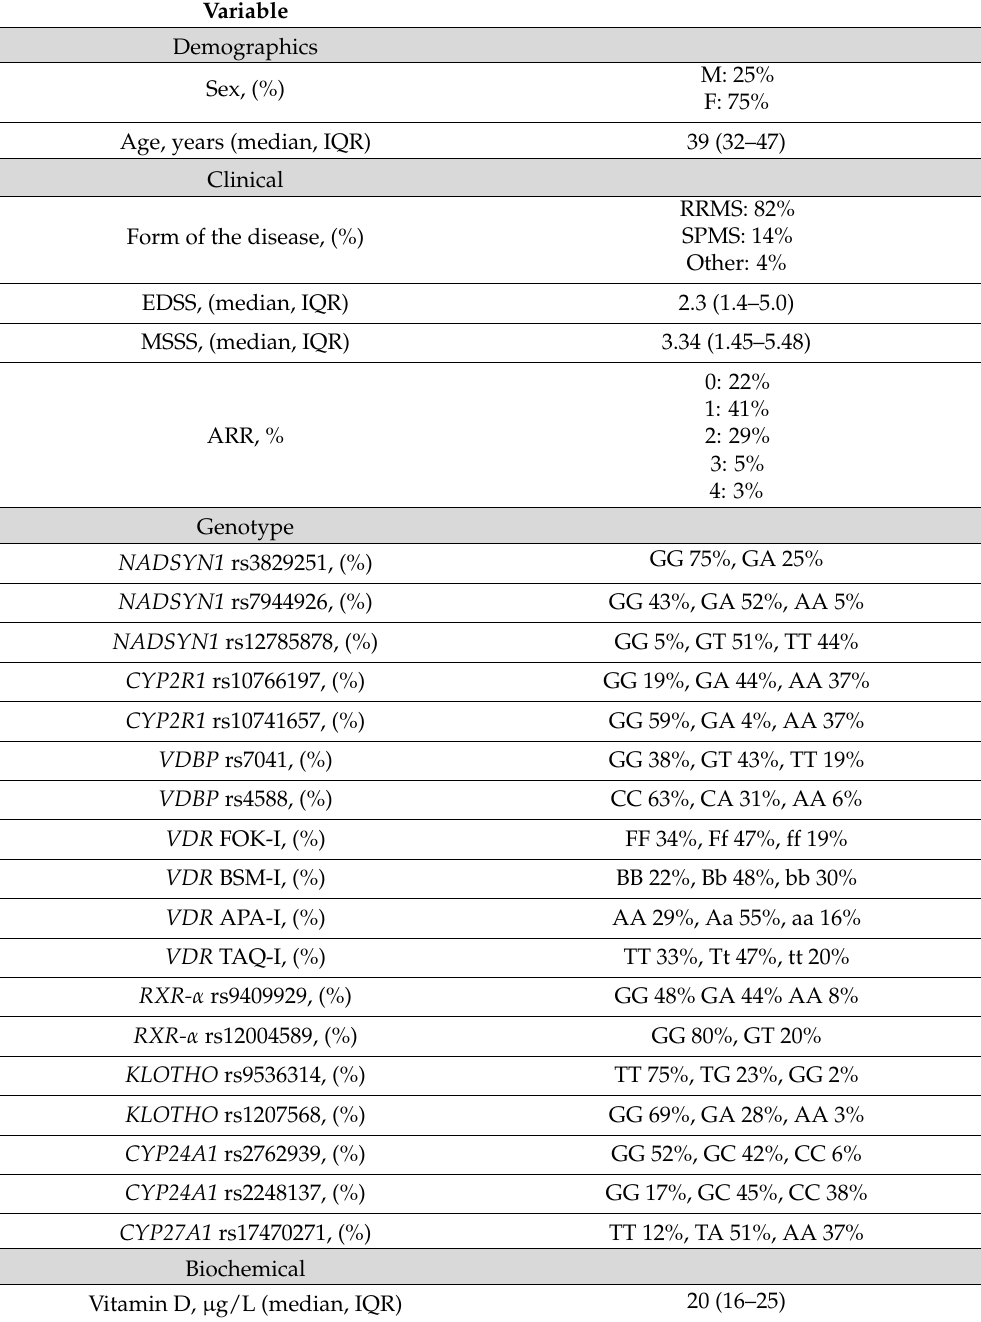
Table 2. Characteristics of the study population (n =